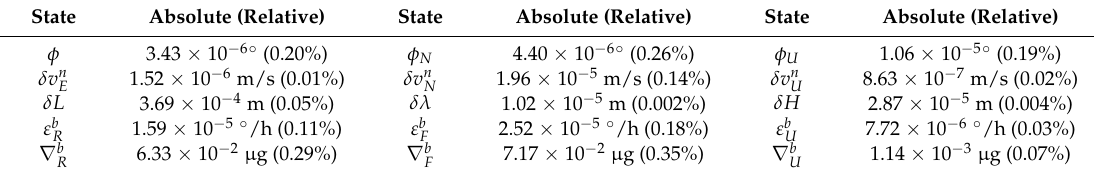
Table 2. The absolute and relative change of the square root of each diagonal element of P k .